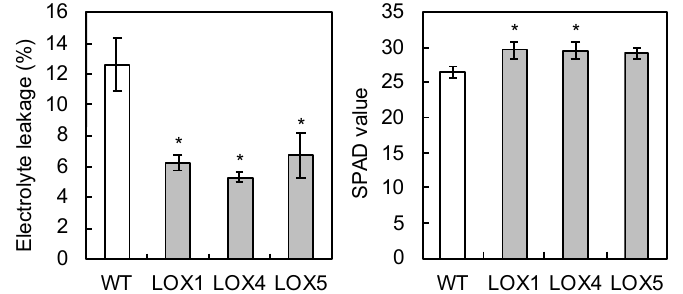
Figure 6. Electrolyte leakage and chlorophyll content (SPAD value) under low-temperature stress conditions at − 2 °C in LOX lines of transgenic Arabidopsis expressing PcLEA14 : values indicate the means ± standard error ( n = 3). * Significantly different from wildtype (WT) at p < 0.05 according to Dunnett’s test.